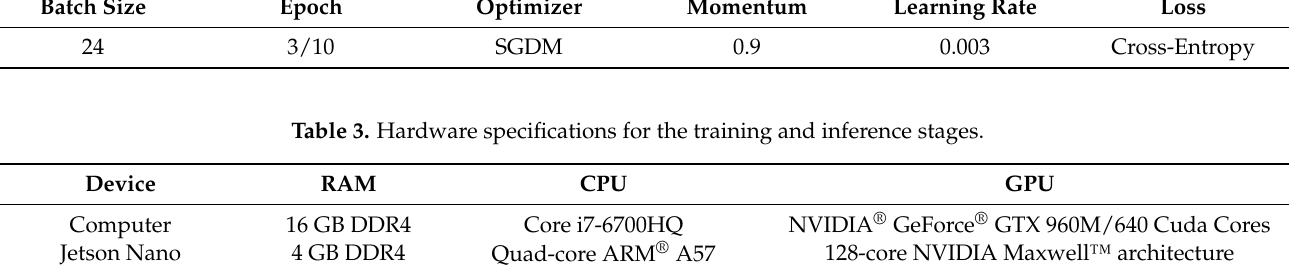
Table 2. Hyperparameters of the training stage: transfer leaning (TL)-based models and custom model. Batch Size